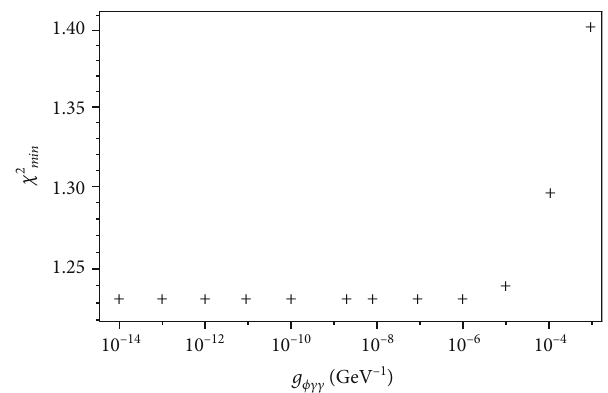
Figure 3: χ 2 vs. g ϕγγ . The plot shows that smaller couplings to min photons are favored.